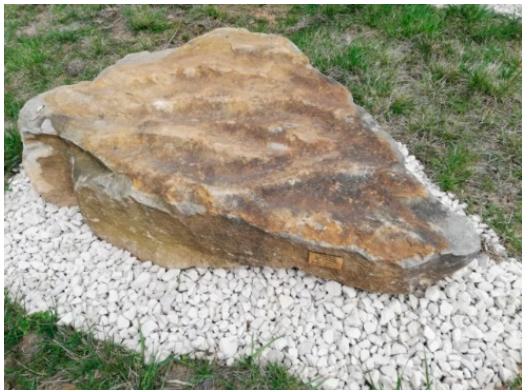
Figure 9. Current ripples (ripple marks) on the surface of Lower Jurassic sandstone from the Ś mi ł ów mine near Szyd ł owiec (No. 7).